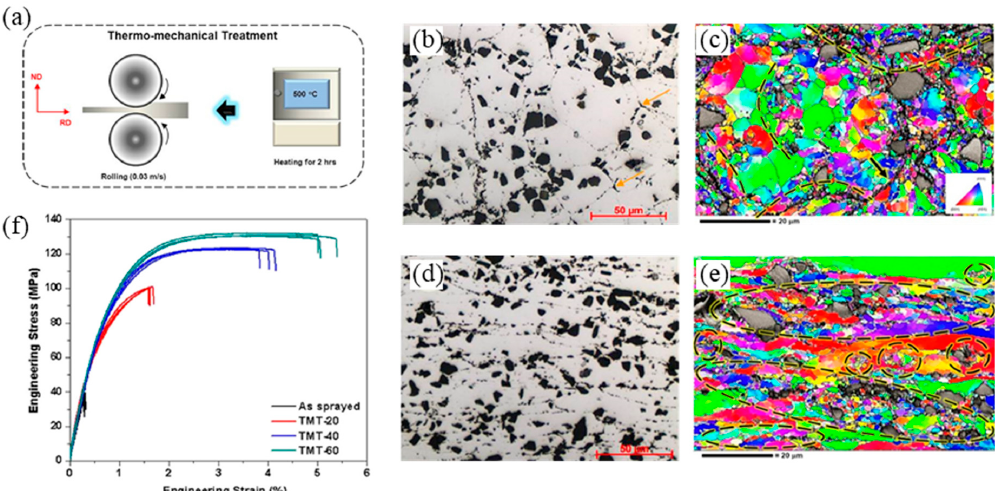
Figure 20. ( a ) Schematic diagram of hot rolling process, ( b – e ) optical micrographs and EBSD results